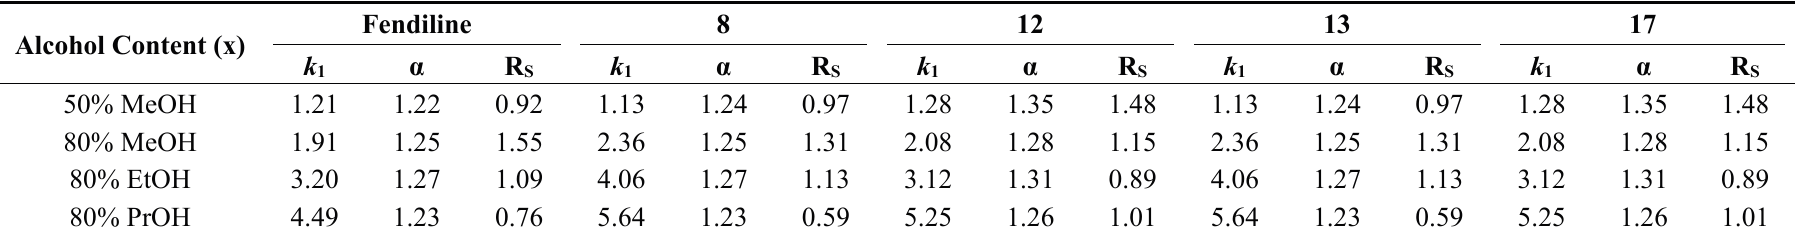
Table 1. Resolution of racemic fendiline and its analogues ( 8 , 12 , 13 and 17 ) on CSP 1 with the variation of the content of methanol (MeOH), ethanol (EtOH) or 2-propanol (PrOH) in acetonitrile (ACN) as a mobile phase containing trifluoroacetic acid (TFA)-triethylamine (TEA) of the constant ratio [MeOH or EtOH or iPrOH-ACN-TFA-TEA, x/(100 − x)/0.1/0.5, v/v/v/v]. Flow rate: 0.5 mL/min. Detection: 254 nm UV. Column temperature: 20 °C. k 1 : Retention factor of the first eluted enantiomer. α : Separation factor. R S : Resolution.